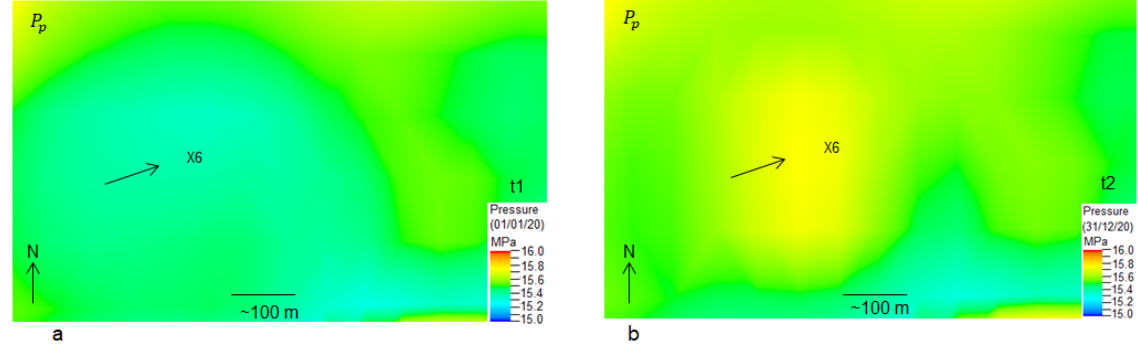
Figure 10. Pore pressure ( 𝑃 (cid:3043) ) and e ff ective stress ( 𝑆 (cid:3032)(cid:3033)(cid:3033)(cid:3032)(cid:3030) ) changes from t1 (1 January 2020) to t2 (31 December 2020) in the short-term case with one well (X6) with a water cut-o ff rate of 5 m 3 /day and a random schedule. The arrows show the location of the maximum observed fl uctuation in 𝑃 (cid:3043) and 𝑆 (cid:3032)(cid:3033)(cid:3033)(cid:3032)(cid:3030) from t1 to t2. The color scale is in MPa. ( a ) is pore pressure at time t1; ( b ) is pore pressure at time t2; ( c ) is e ff ective stress at time t1; ( d ) is e ff ective stress at time t2. 4.5. Case D This scenario has been performed on vertical well X6. The schedule timeline of one year has been adopted from Figure 8. There was no water cut-o ff rate limit set in this sce- nario; hence, the maximum water production rate (WWPR) increases up to 43 m 3 /day and remains less than 20 m 3 /day throughout the production and injection period of one year, respectively (Figure 11c). The FPR is sustained in this case by gas injection and increases to up to a maximum value of 15.62 MPa with slight variation during the gas production cycles in the one-year period (Figure 11a). The alteration in WBHP is directly proportional to the gas production cycles without a water cut-o ff limit. As shown in Figure 11b, the WBHP reaches a maximum value of 18.8 MPa and a minimum value of approximately 13.8 MPa. The well gas injection rate (WGIR) varies during the year, having a minimum injection rate of approximately 32,000 m 3 /day and a maximum rate of about 60,000 m 3 /day, whereas the well gas production rate (WGPR) has minimum and maximum values of 16,000 m 3 /day and 40,000 m 3 /day, respectively (Figure 11d).